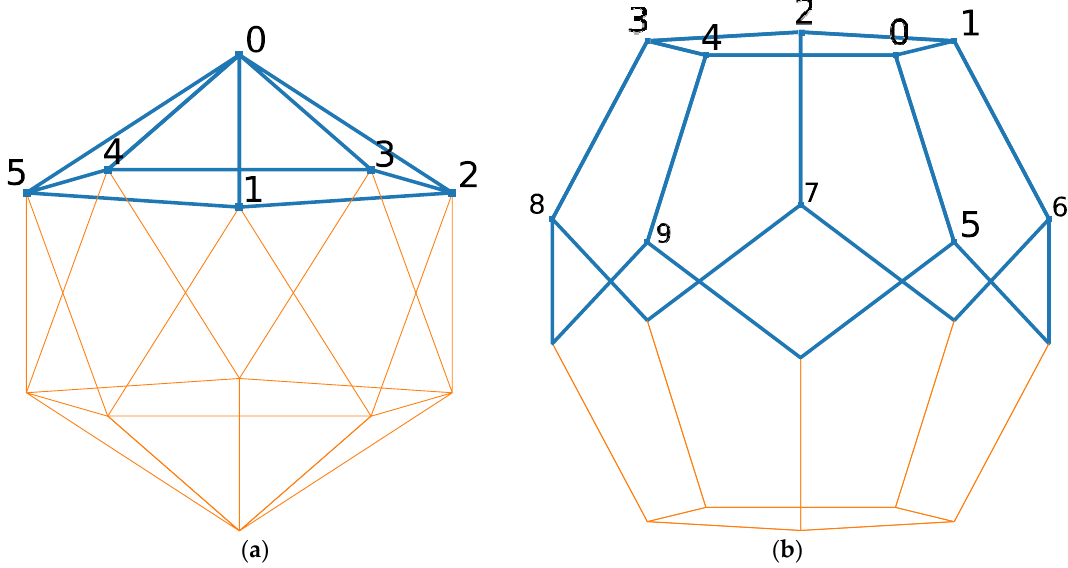
Figure 2. The numbering n m of the vertices of: ( a ) the icosahedron (for an even m ) as in Table 1 on the left; and ( b ) the dodecahedron (for an odd m ) as in Table 2 on the right.